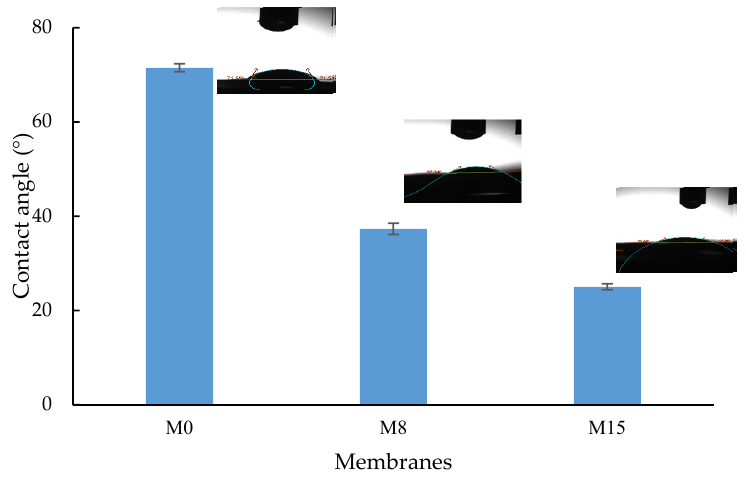
Figure 4. Contact angle of the prepared membrane.